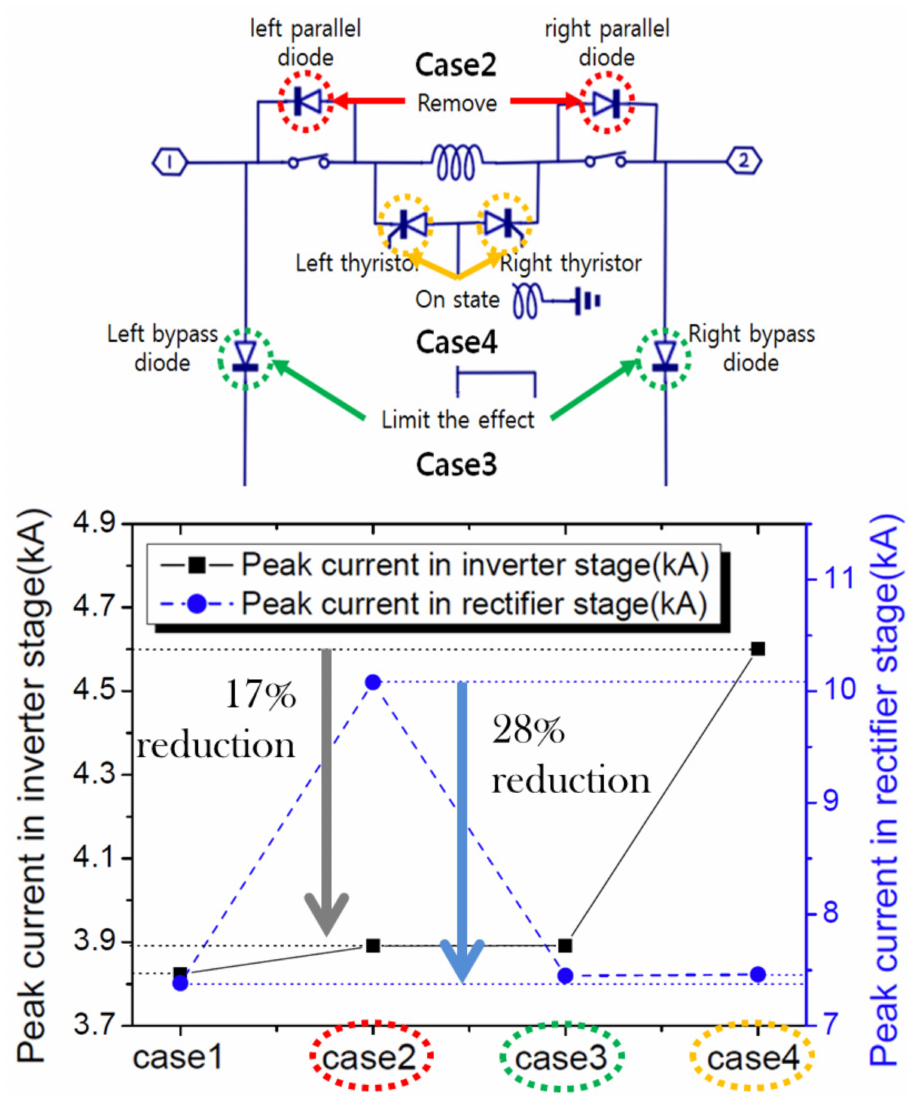
Figure 8. Peak current in the inverter and rectifier stage when different cases; Case 1: All elements are operating under normal conditions; Case 2: Under normal conditions, the parallel diodes are removed; Case 3: Under normal condition, the bypass diode is changed to a thyristor, the mechanical switch is turned off, the changed thyristor is also turned off (The reverse charging process works the same.); Case 4: Under normal conditions, resonant current is emitted without specifying the direction of the thyristor (both the left and right thyristors are turned